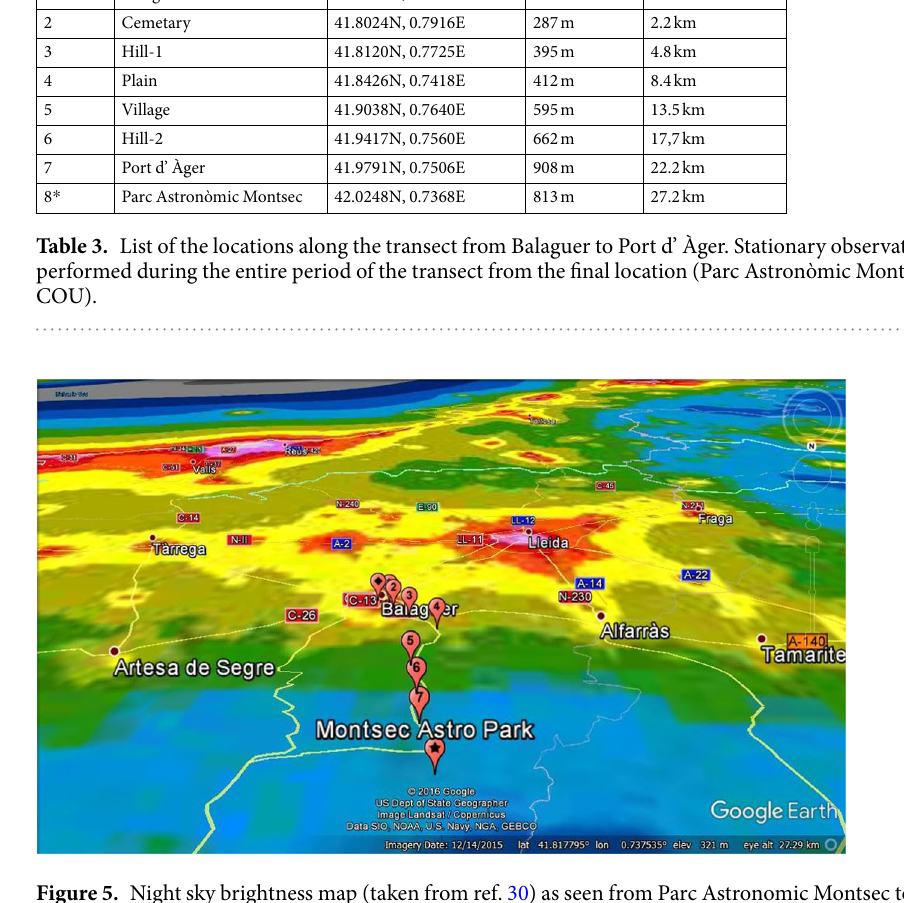
Figure 5. Night sky brightness map (taken from ref. 30) as seen from Parc Astronomic Montsec towards